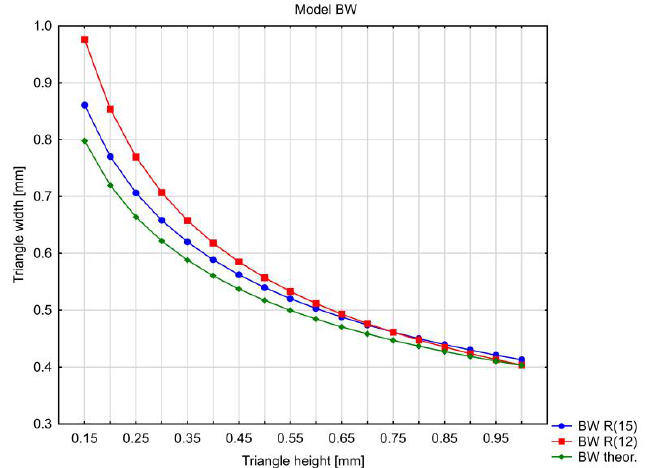
Figure 11. Comparison of performed regression models (BW black and white card) with theoretical curve. Blue curve is the model that includes all responses; red curve is the model without the three rejected surveys; and green curve is the theoretical values according to P c